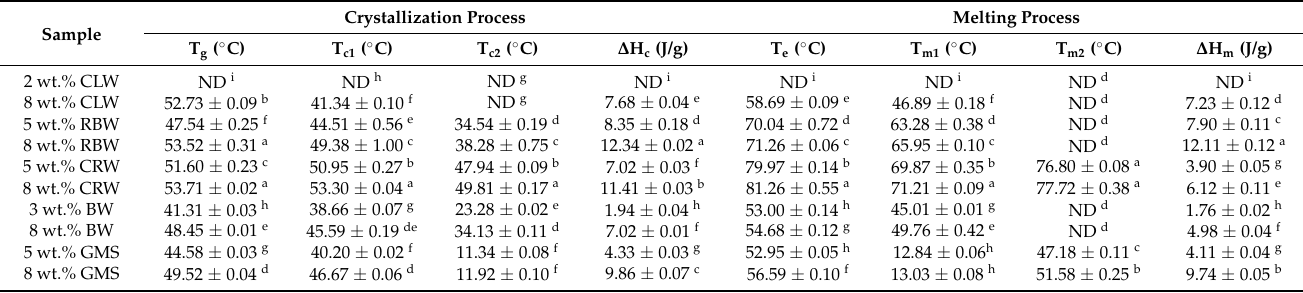
Table 1. Thermodynamic parameters of oleogels formed by different types of gelling agent. Crystallization Sample